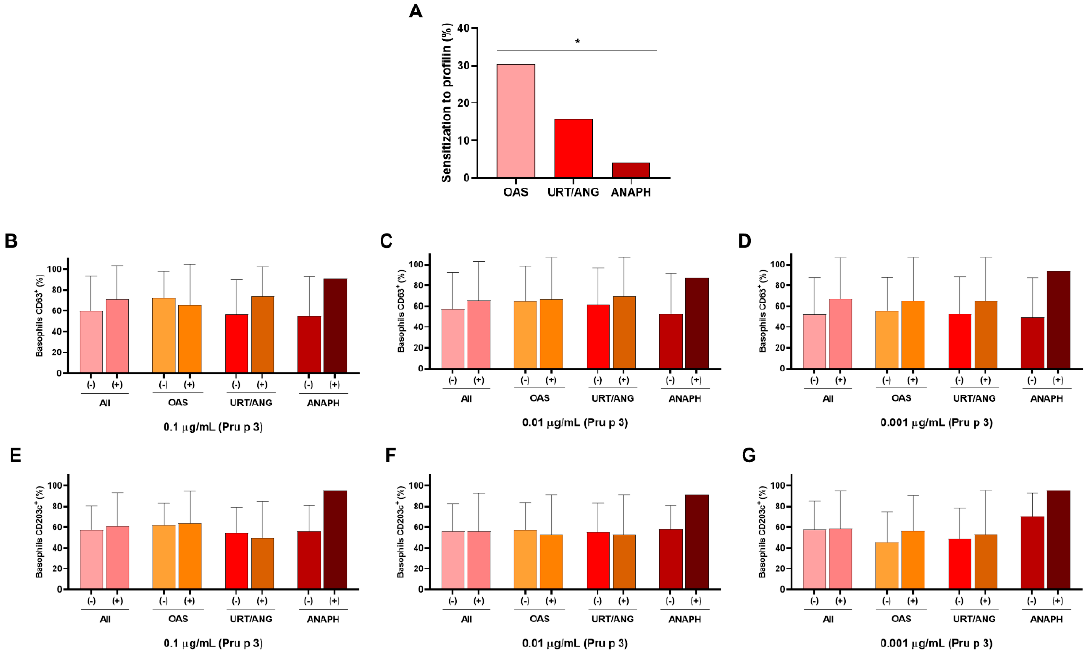
Figure 5. Sensitization to profilin ameliorates the severity of symptoms from LTP-allergic patients. ( A ) The percentage of sensitized patients to profilin was determined, showing a decrease in the number of LTP-allergic patients with sensitization to profilin in relation to the increase in severity of symptoms. Moreover, levels of %CD63 + ( B – D ) and %CD203c high ( E – G ) were compared between LTP-allergic patients sensitized or not to profilin at the three selected concentrations of Pru p 3, not showing changes in any case. * p < 0.05. ANAPH, anaphylaxis; OAS, oral allergy syndrome; URT/ANG, urticaria/angioedema.